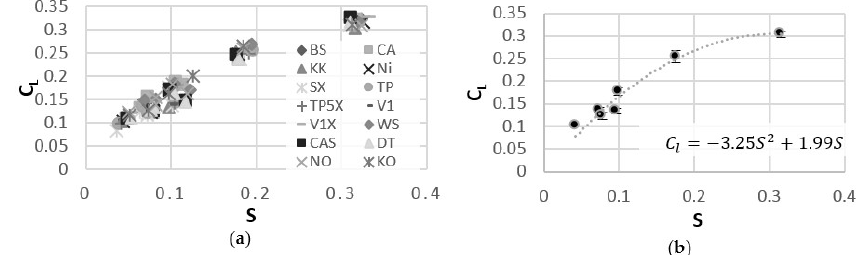
Figure 4. ( a ) Coefficient of lift as a function of spin factor; ( b ) Coefficient of list as a function of spin factor for KK. Error bars indicate the standard deviation of